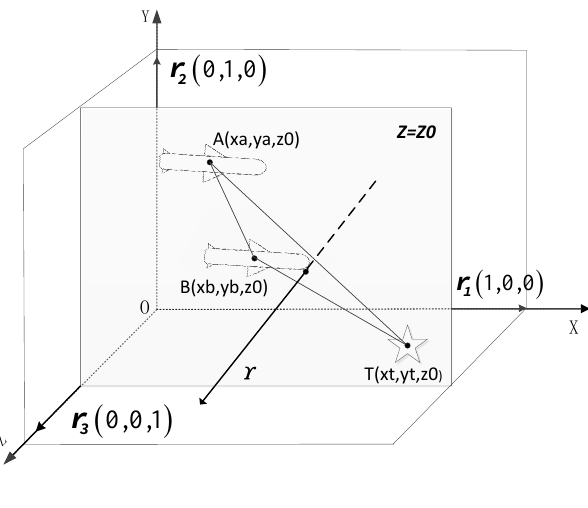
Figure 3. Judge on spatial relationship.